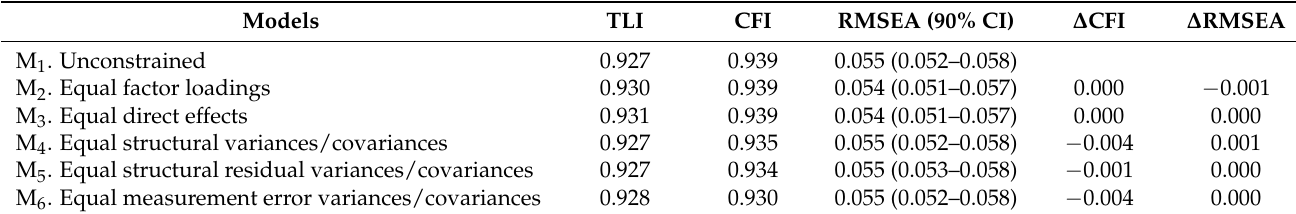
Table 7. Multigroup analyses results for teleworking overload